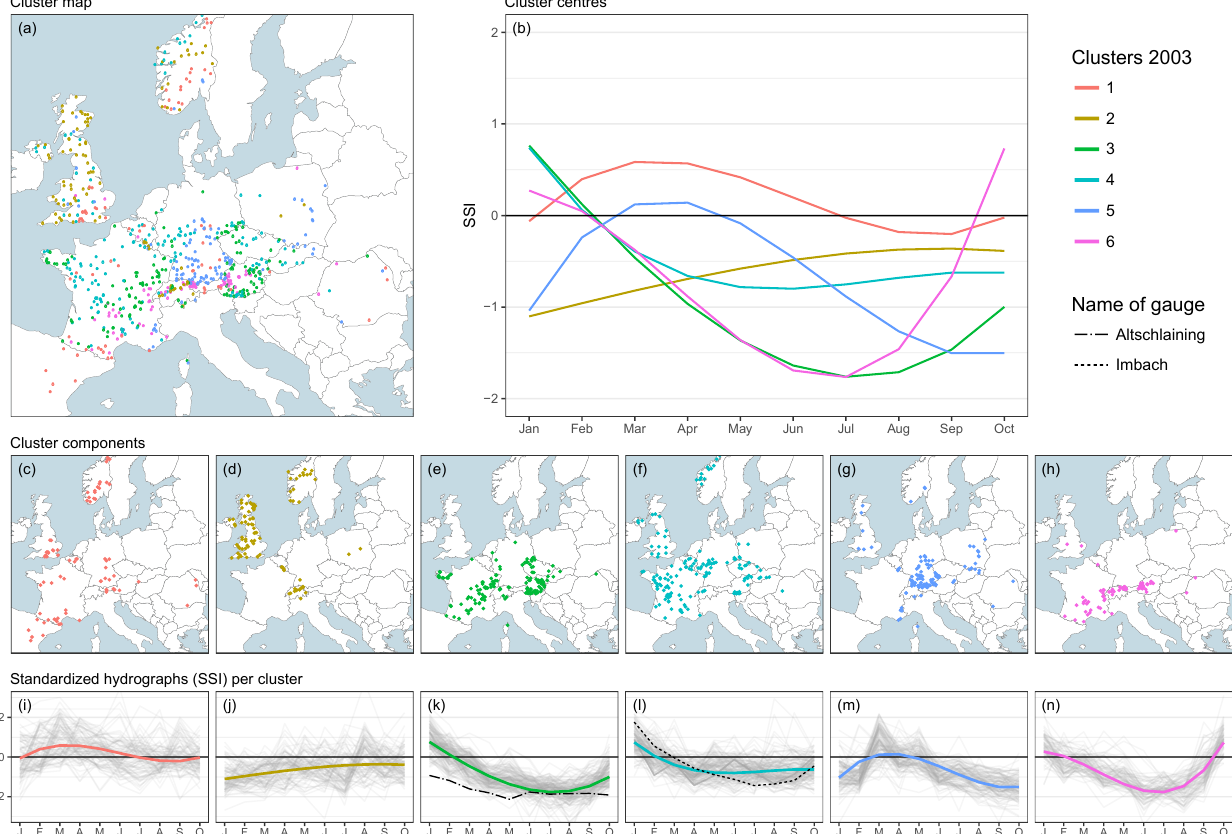
Figure 6. Clustering of the low flow event of 2003 based on monthly standardized streamflow index values SSI of the January–October period. (a) Combined cluster map showing allocation of catchments to the clusters, (b) combined map of functional models of each cluster, (c–h) cluster component maps, and (i–n) synoptic plots of standardized monthly hydrographs (indicated by thin grey lines) of Cluster 1–6 together with the functional model of each cluster center (bold colored line). Altschlaining is marked by a dotted and dashed black line, Imbach is marked by a dashed black